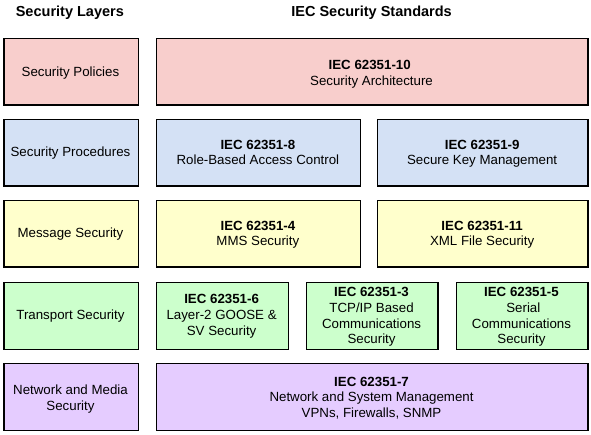
Figure 5. IEC 62351 security